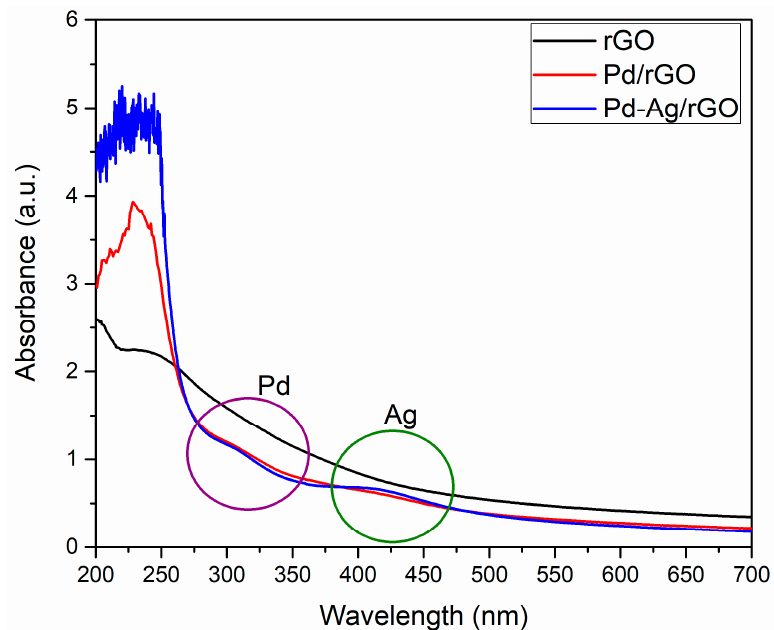
Figure 1. UV-Vis absorption spectra of prepared rGO, Pd/rGO, and Pd-Ag/rGO nanostructures using plant leaf extract.